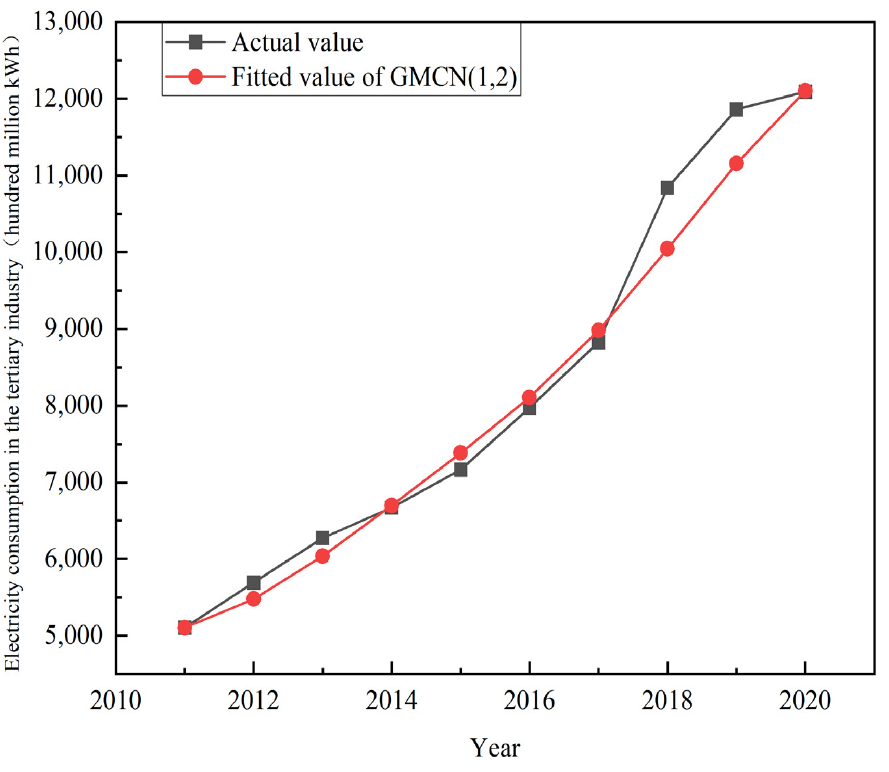
Figure 2. Fitting between predicted and actual values.